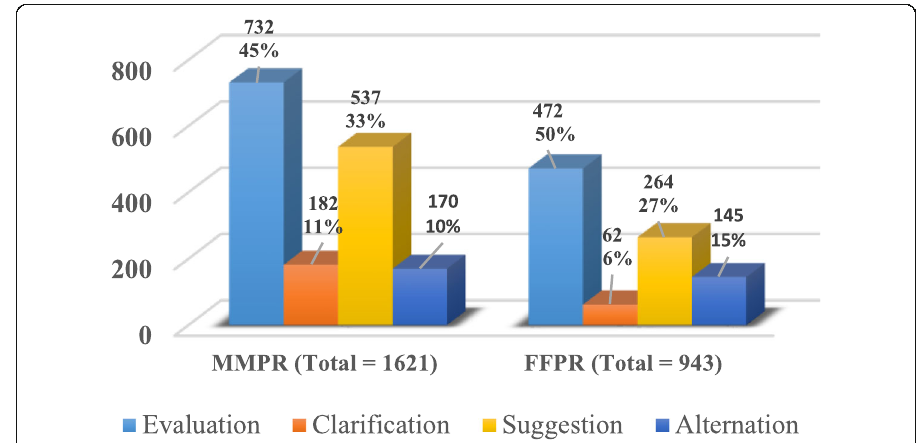
Fig. 3 Feedback distribution percentage by group and by